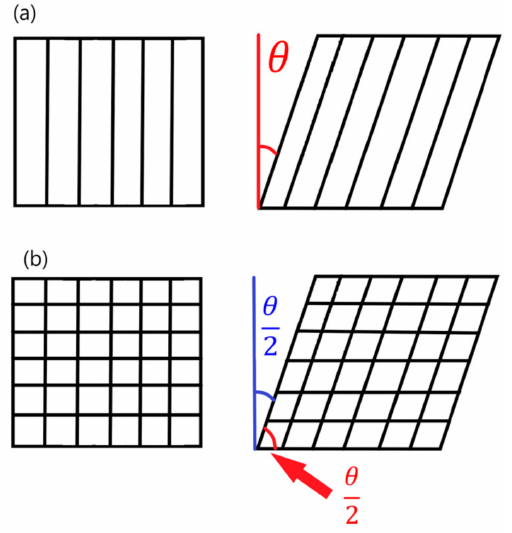
Figure 5. Local fiber orientations neglecting the effects of draping ( left ) and accounting for them ( right ) for unidirectional ( a ), and bi-directional plain weave ( b ) materials. Ply thickness variation is a related negative effect that can occur when draping plies over complex mold geometries. Wrinkling of a ply due to fabric shearing creates deviations in the ply thickness. Similar to fiber angle deviations, localized changes in ply thickness can create stress concentrations which reduce structural performance. During draping simula- tion, the ply thickness at each element location is calculated based on the degree of fabric shear, θ . The thickness of each element within a FEA model is given by Equation (1) [19]. Where t is the local ply thickness of an element following ply draping and t 0 is the thickness of the ply when laid